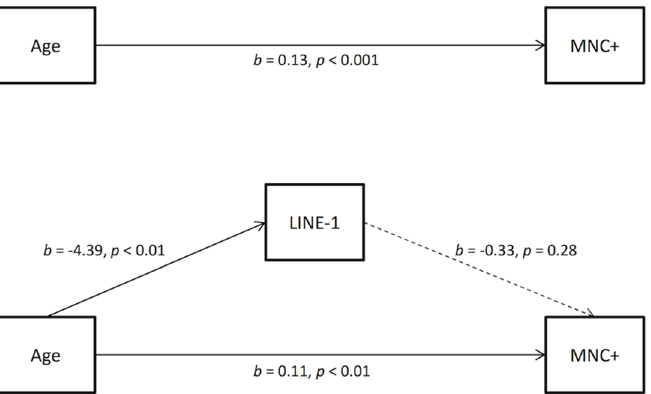
Fig 1. Causal model for age and LINE-1 hypomethylation prediction of MNC+. (Top) the path from age to MNC+. (Bottom) another path from age through LINE-1 hypomethylation to MNC+. Arrows connecting one variable to another represent unstandardized regression coefficients of the path. Solid lines are significant whereas dashed lines are not.